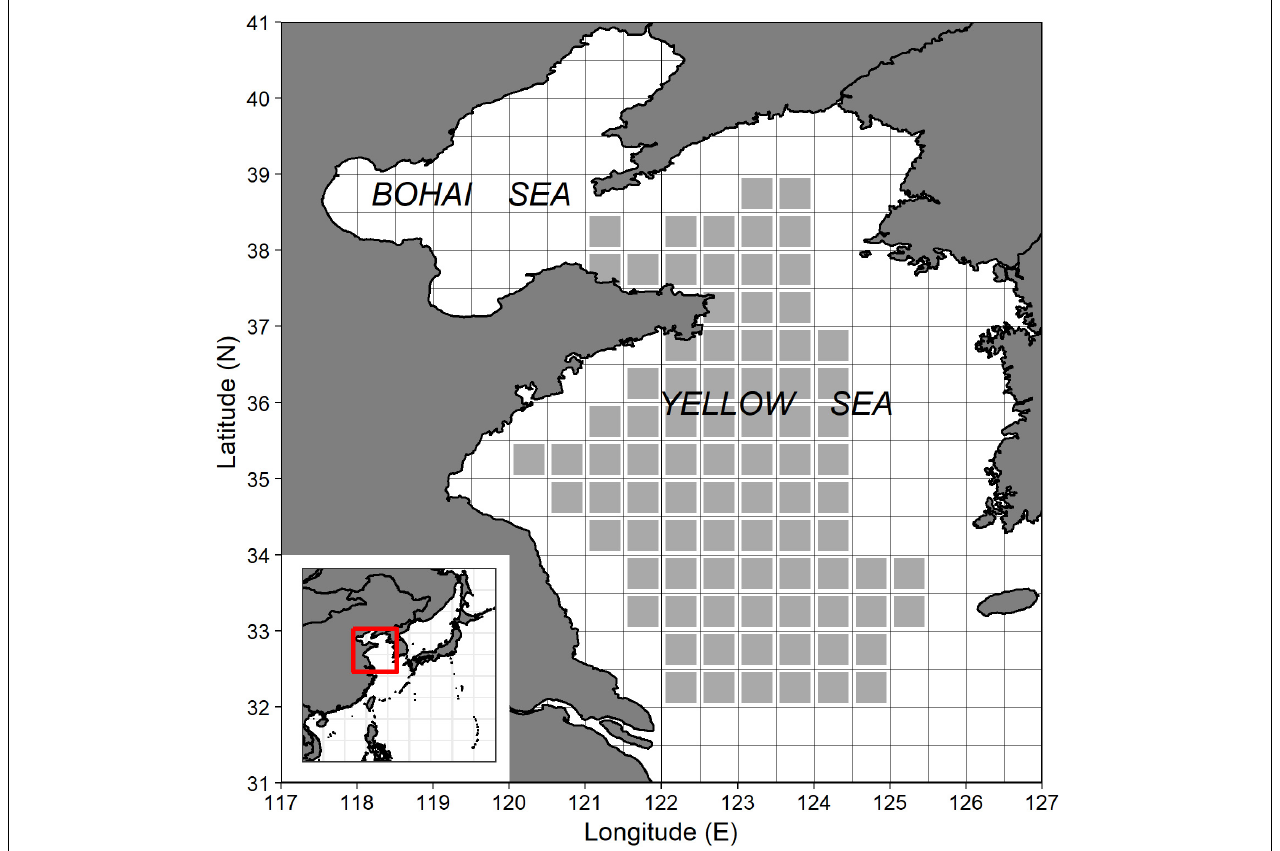
FIGURE 1 | Map of Yellow Sea and bottom trawl survey stations (gray squares) during autumn from 2000 to 2018.